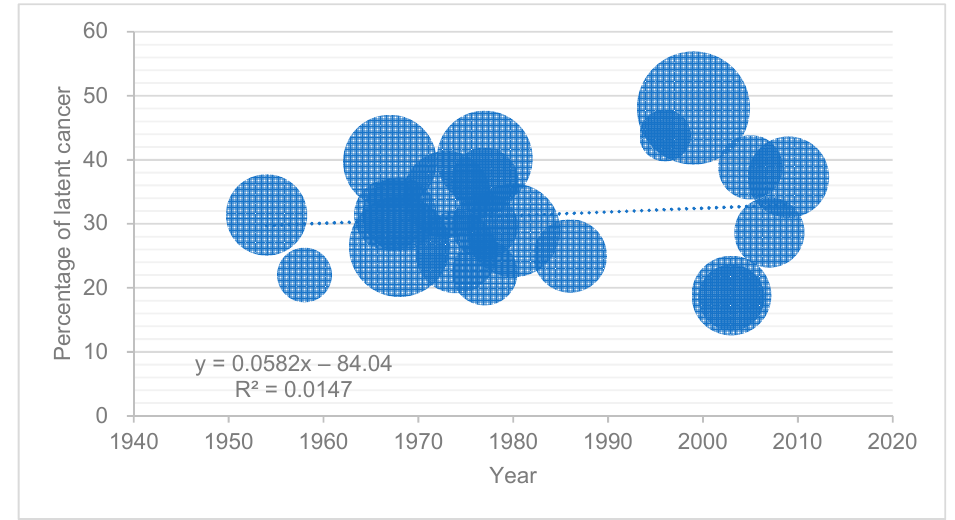
Figure 1. Prevalence of latent PC in studies of Caucasians in the US and Europe.